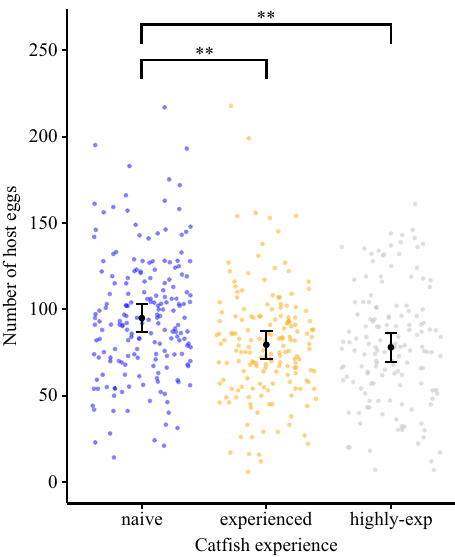
Fig. 3 Host clutches were larger in treatments with naive cuckoo cat fi sh. On average, host clutches in the experienced and highly experienced treatments were 17% smaller than the host clutches in the naïve treatment (GLMM with Gaussian error distribution; n = 509 clutches; naïve vs. experienced treatment: z = − 2.928, P = 0.00341; naïve vs. highly experienced treatment: z = − 3.130, P = 0.00175). The black dots represent mean values from model estimates and associated mean standard errors (whiskers) predicted across the experimental period. Coloured dots represent the observed data points (i.e., individual host clutch sizes) for naïve (blue, n = 191 spawnings in 6 replicate tanks), experienced (orange, n = 174 spawnings in 6 replicate tanks), and highly experienced (grey, n = 146 spawnings in 6 replicate tanks) cuckoo cat fi sh treatments. Asterisks denote statistically signi fi cant differences (** for P < 0.01). Source data are provided as a Source Data fi le.